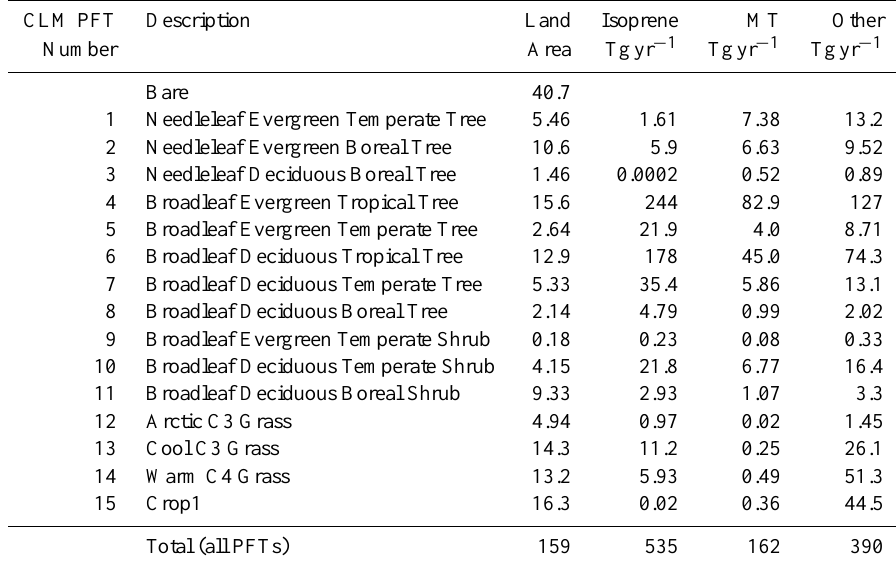
Table 3. CLM4 global land area (10 12 km 2 ) and isoprene, monoterpene (MT) and other (VOC and CO) emissions for individual plant functional types estimated using MEGAN2.1 algorithms in CLM4 for year